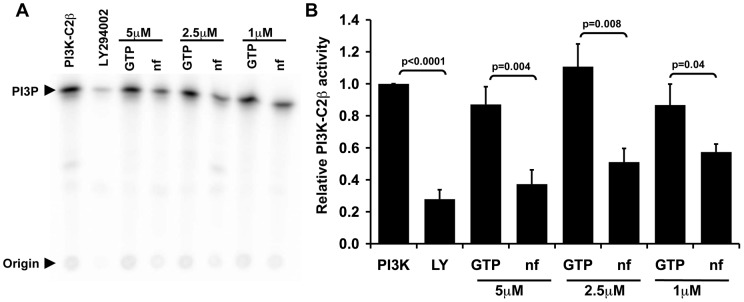
Nucleotide free Ras inhibits PI3KC2β activity.(A) The in vitro kinase activity of purified PI3KC2β was assayed in the presence of nucleotide-free (nf) Ras or Ras loaded with GTPγS (5 μM, 2.5 μM, and 1 μM). LY294002 (10 μM) was used as a negative control. The radioactive phospholipid products were extracted and eluted on a TLC plate. (B) Nucleotide-free Ras dose dependently inhibits PI3KC2β. LY294002 (10 μM; LY) inhibits PI3KC2β activity while Ras-GTP (5 μM, 2.5 μM, and 1 μM) does not. The graph represents relative kinase activity normalized to PI3KC2β alone ± S.E.M. from 4–6 independent experiments.